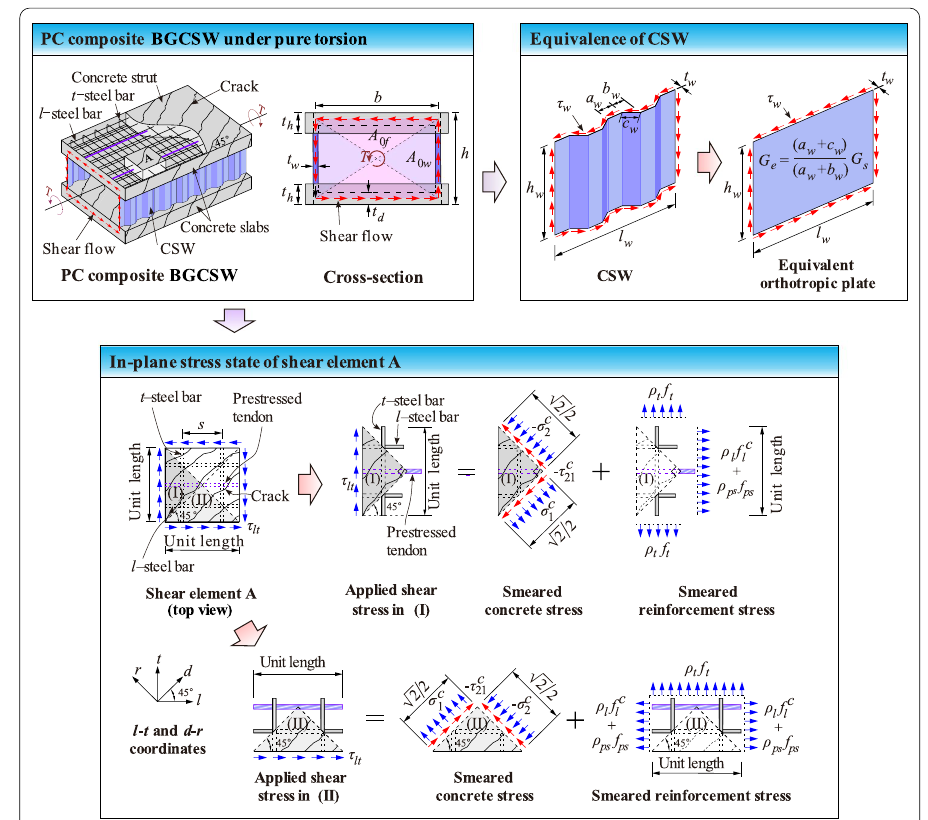
Fig. 10 Force decomposition of PC composite BGCSW under pure